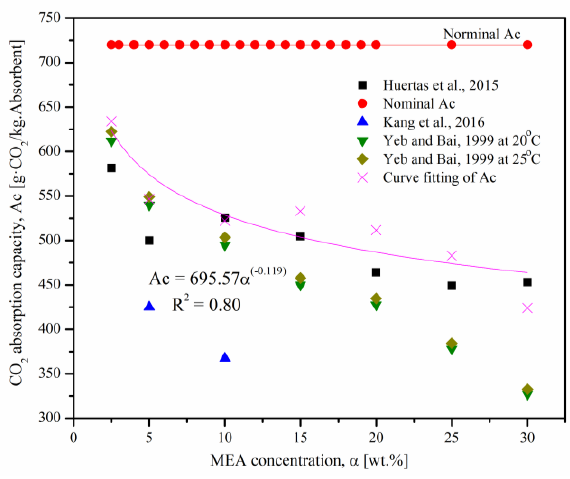
Figure 2. Validated curve of CO 2 absorption capacity in aqueous MEA absorbent adapted from literature. Kang et al., 2016 [17] used a stirred reactor with 400 mL of 5, 10, and 30 wt.% of aqueous MEA and 290 mL/min of 15 vol.% of CO 2 diluted in flue gas (temperature varied from 25 to 70 ◦ C and atmospheric pressure). Huertas et al., 2015 [41] used a stirred reactor with 500 mL of <50